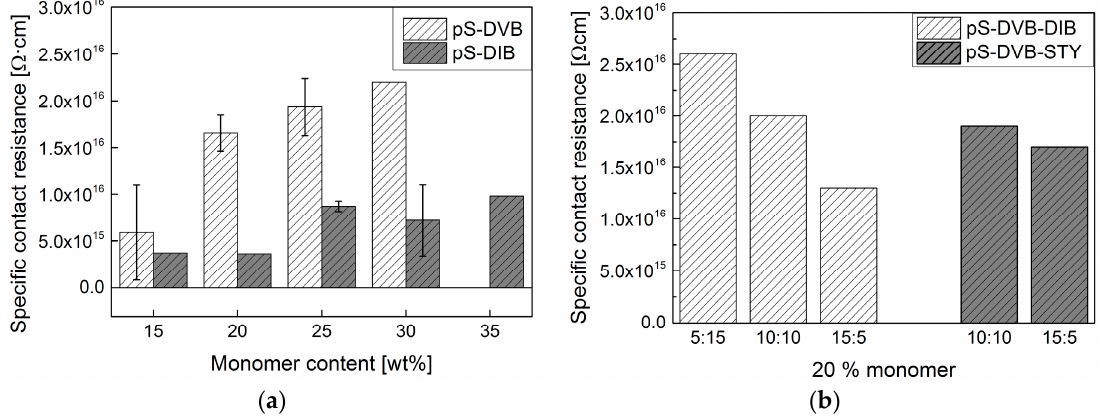
Figure 9. Specific contact resistance of sulfur materials: ( a ) copolymers; ( b ) terpolymers. Measured after 0–3 months of synthesis.